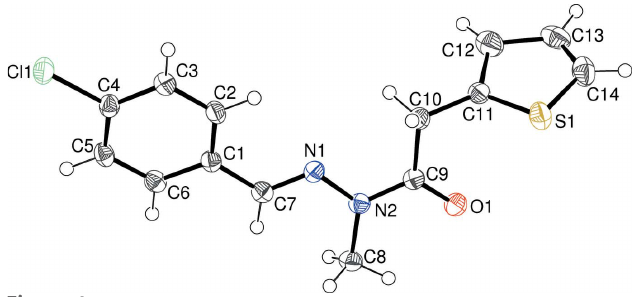
Figure 4 The molecular structure of (IV), showing 50% probability displacement ellipsoids. Only the major orientation of the thiophene ring is shown.